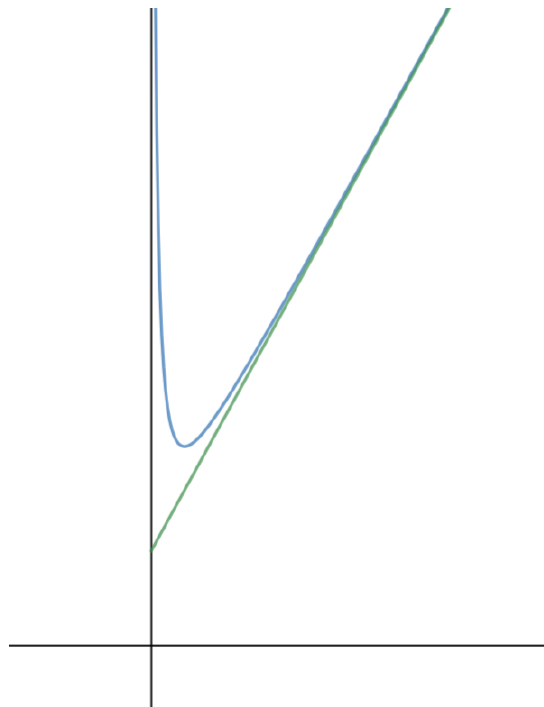
Figure 3. A typical graph of L ( a ) , along with t + ak r which appears to be asymptotic to it. L ( a ) appears to be continuous, strictly convex and to approach + ∞ as a → 0 + and as a → + ∞ . In a similar way to the area formulation, we first show that there exists a unique curve which minimizes the